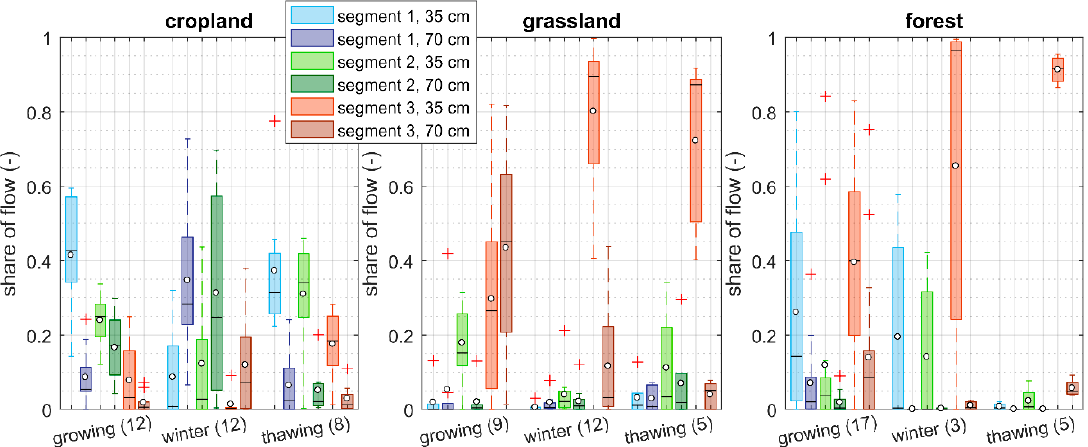
Figure 10. Di ff erences of subsurface flow shares depending on land use and season (dot: mean, number Figure 10. Differences of subsurface flow shares depending on land use and season (dot: mean, of events: number of events: brackets).